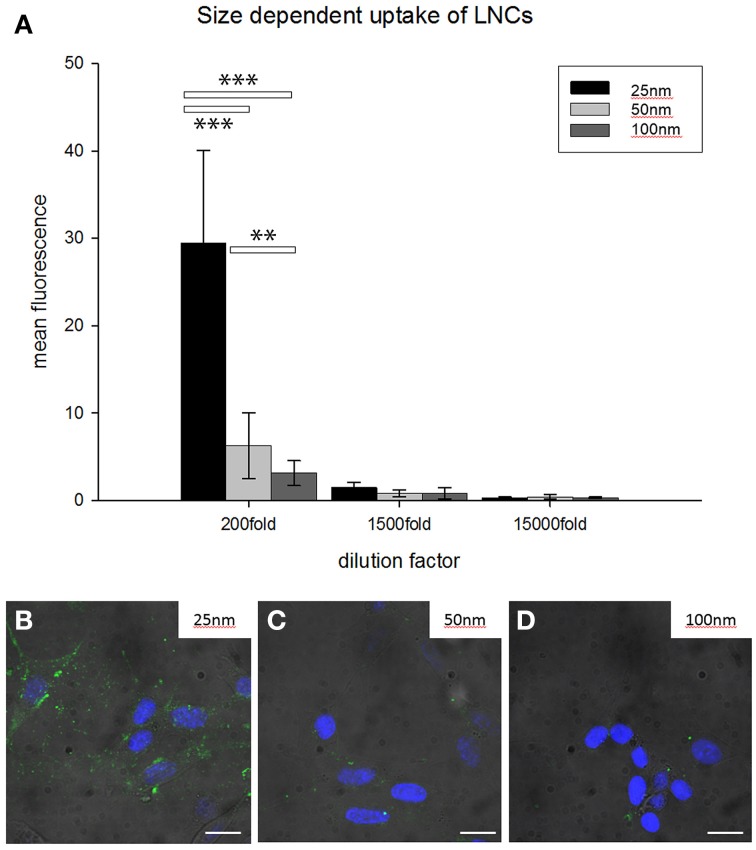
Size-dependent internalization of unfunctionalized FITC-loaded LNCs in HEI-OC1 cells. (A) Bar chart classifies 25 nm-sized NPs to be internalized most efficiently while 100 nm LNCs were internalized with the least efficiency (**p < 0.01, ***p < 0.001, ANOVA, error bars denote standard deviation). 200–1500 times dilution of LNCs shows significant differences. (B–D) Representative examples of HEI-OC1 cells treated with FITC-loaded LNCs (200 times dilution); diameter of LNCs is denoted in the upper right of the micrograph. Green fluorescence is FITC from LNCs, blue fluorescence is DAPI, scale bars 10 μm.